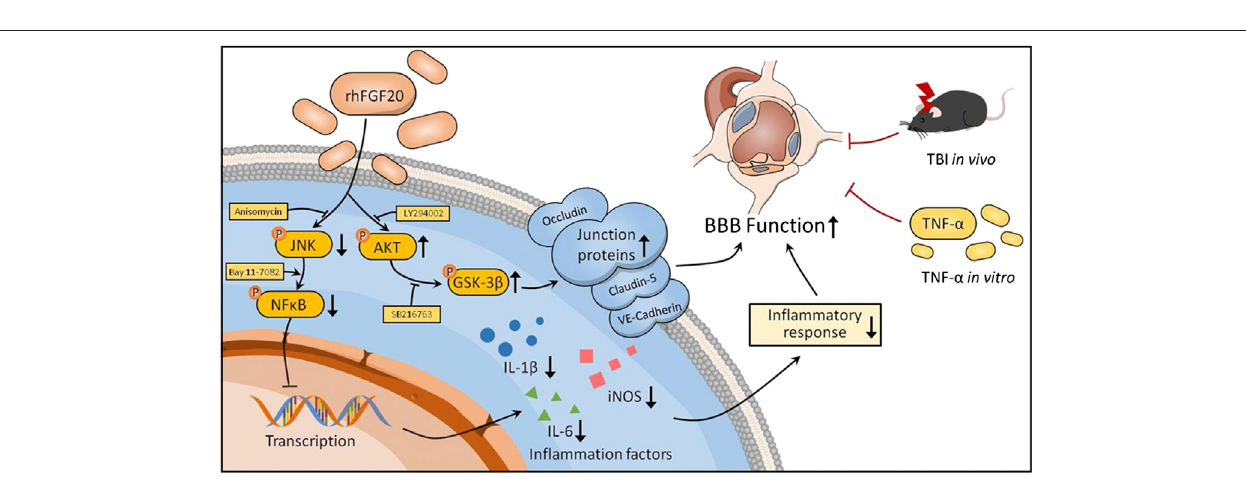
FIGURE 11 | Potential signaling pathways involved in rhFGF20-mediated protection against BBB disruption both in vivo in TBI mice and an in vitro in a TNF- α -induced HBMEC model. rhFGF20 upregulates junction proteins via the AKT/GSK3 β pathway and inhibits proin fl ammatory cytokine expression by suppressing the JNK/NF κ B pathway, eventually protecting against BBB